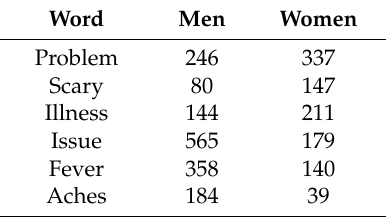
Table 3. Differences in negative words between men and women.